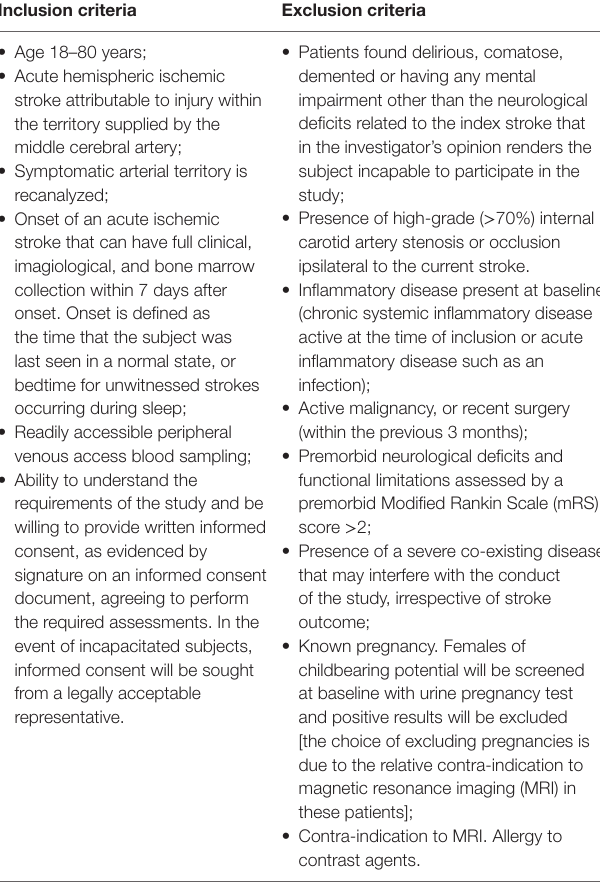
tablE 1 | Inclusion and exclusion criteria for the